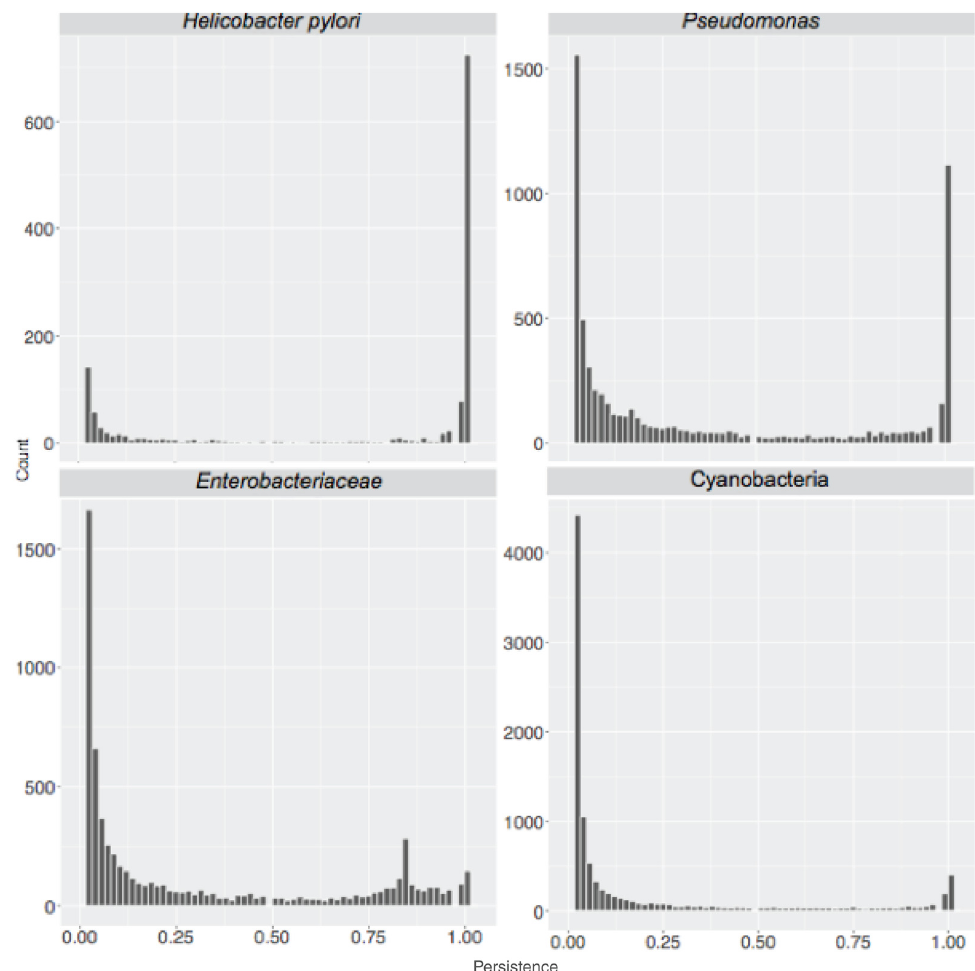
Figure S2. Persistence of Domain Architecture Based (DAB) clusters. The plots show frequency of DAB clusters according to their